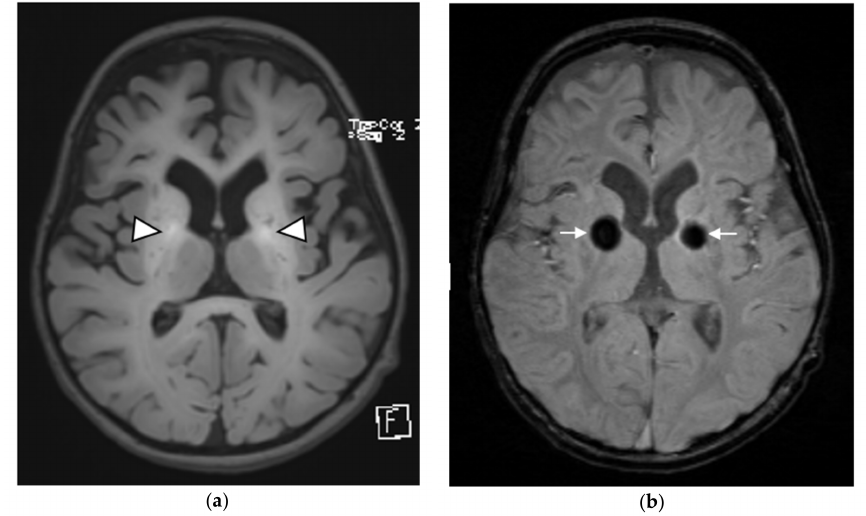
Figure 1. Patient 1